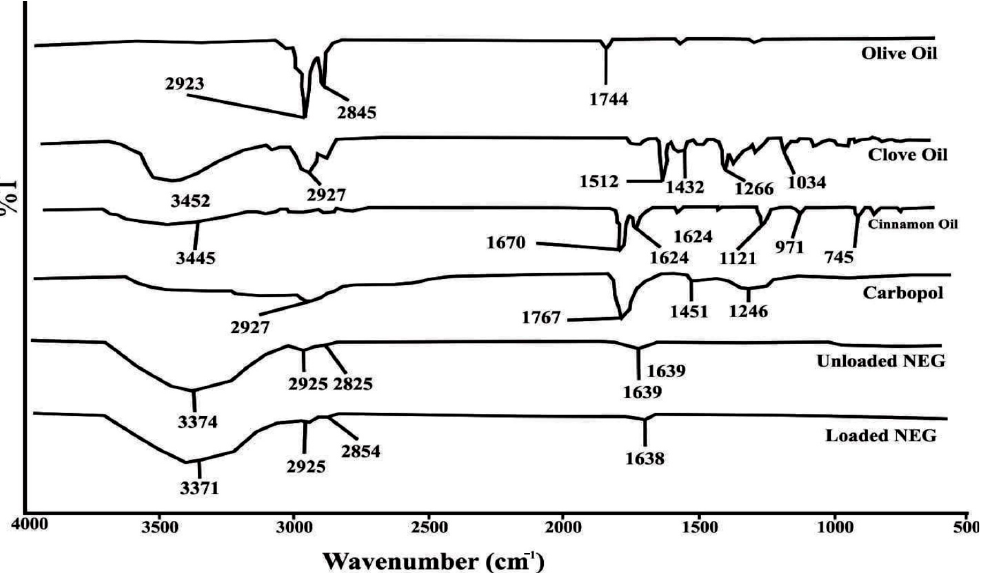
Figure 4. FTIR analysis of the active ingredients, excipients, blank nanoemulgel, and essential oil-loaded nanoemulgel formulation.